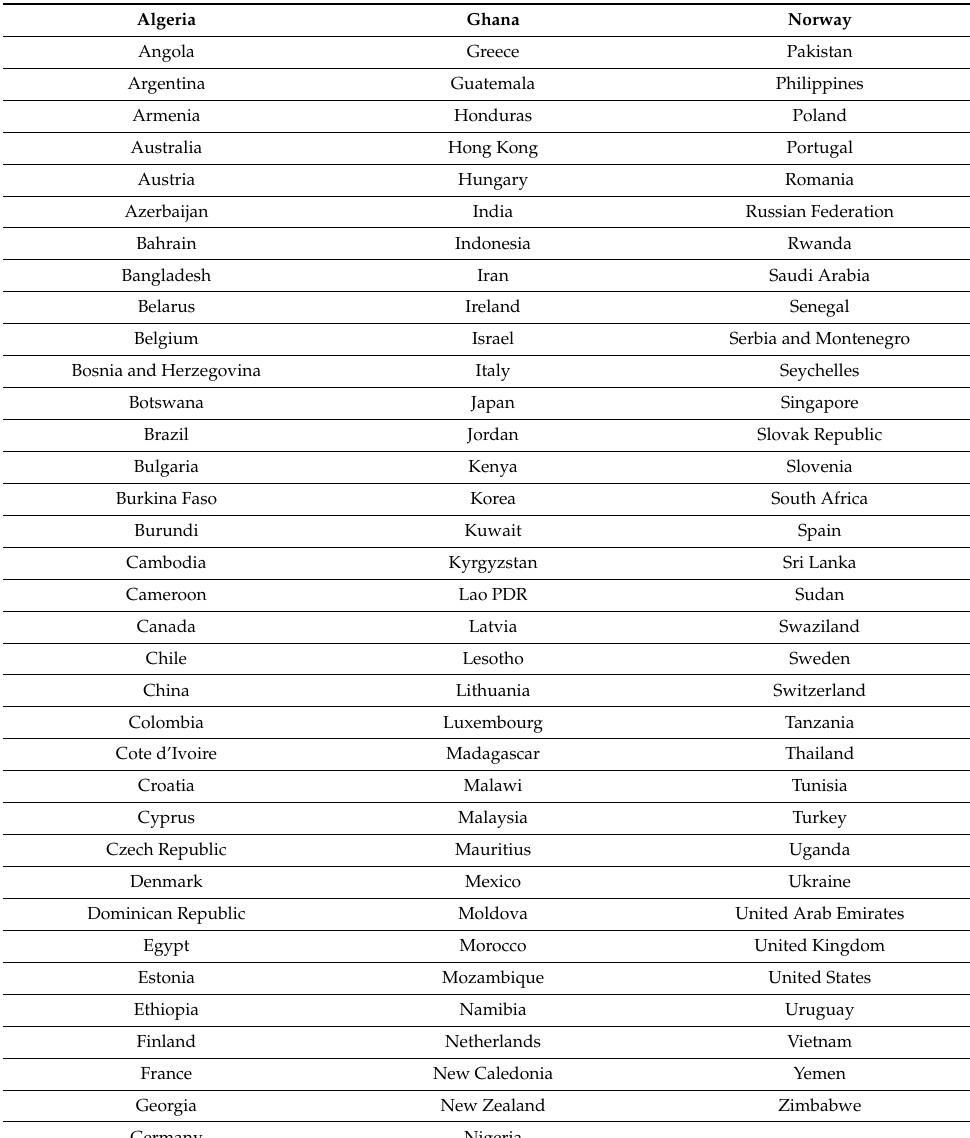
Table A2. List of